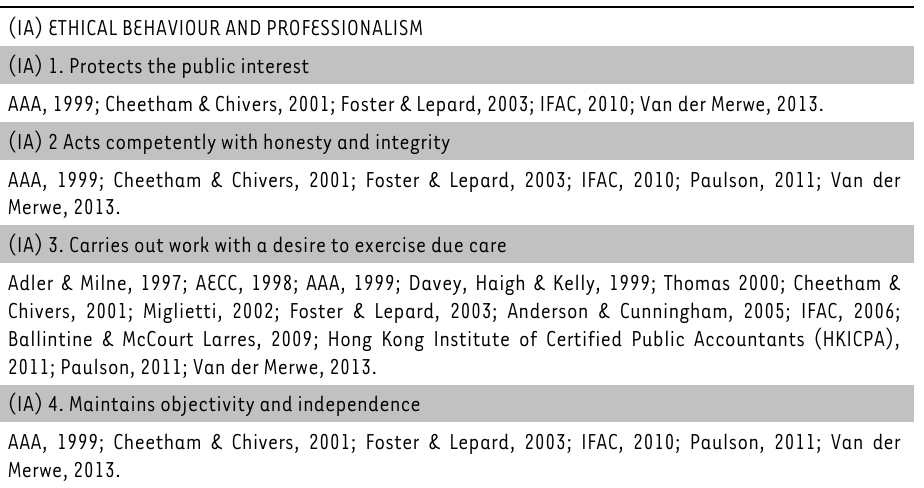
Summary of the pervasive skills that can be developed using collaborative learning